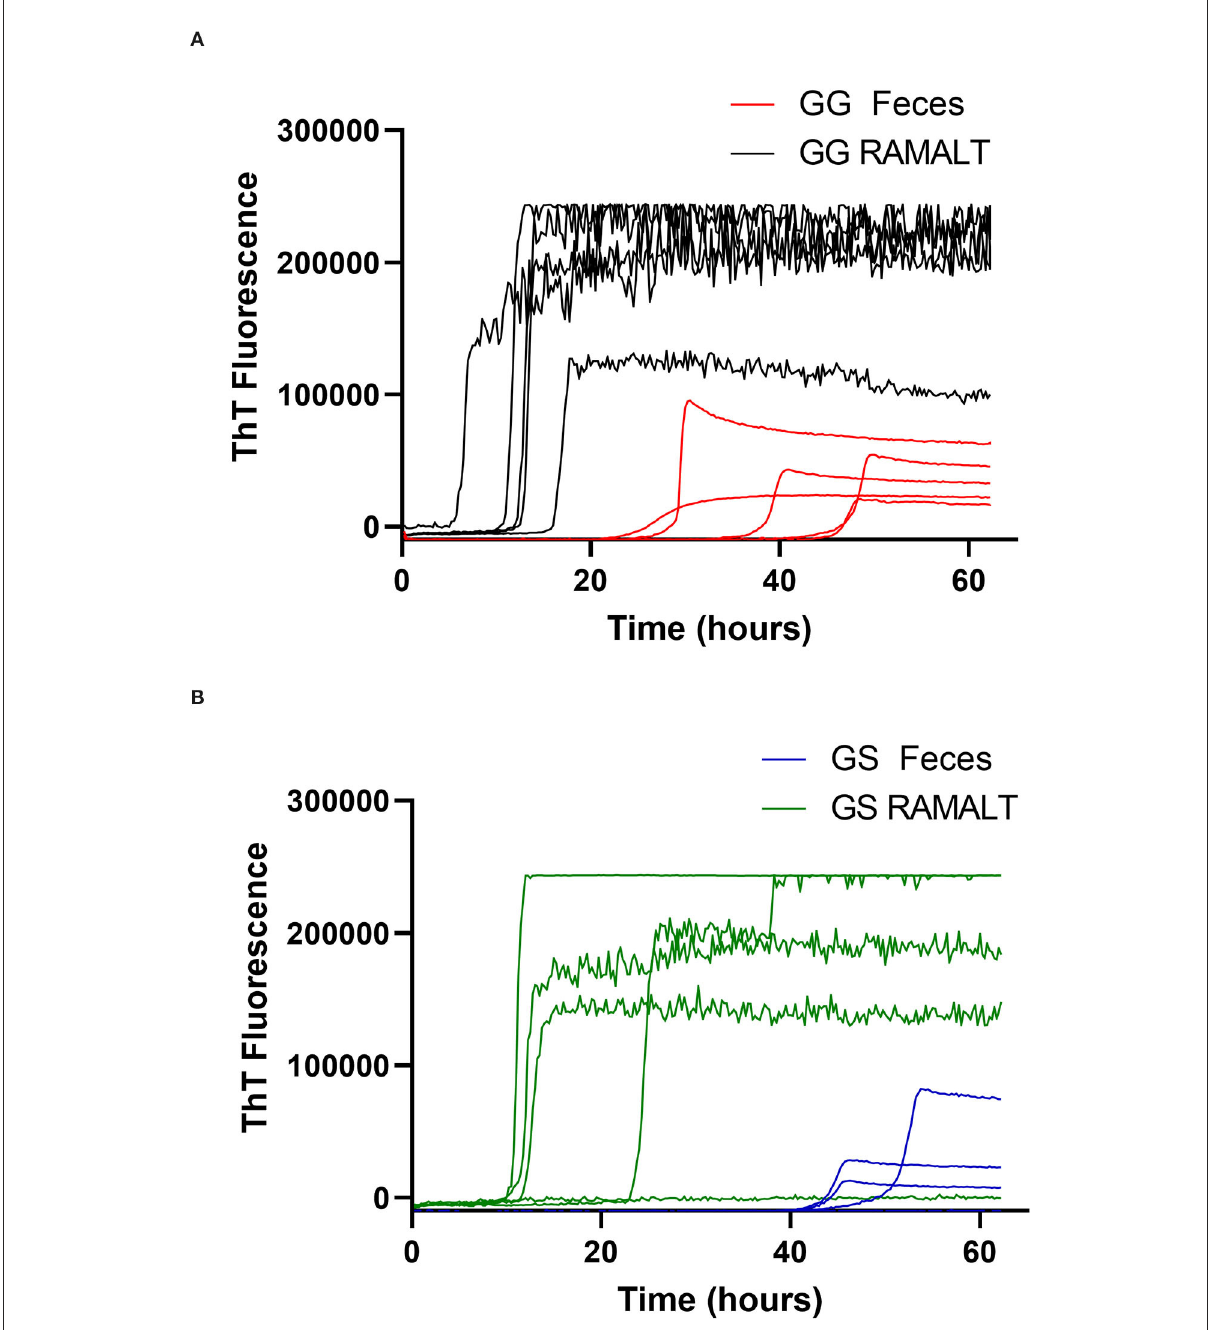
FIGURE3 White-tailed deer genotype influence on RT-QuIC reaction kinetics. (A,B) Raw fluorescence traces for 96 GG and 96 GS deer comparing RAMALT fluorescence values and time to threshold to fecal values.